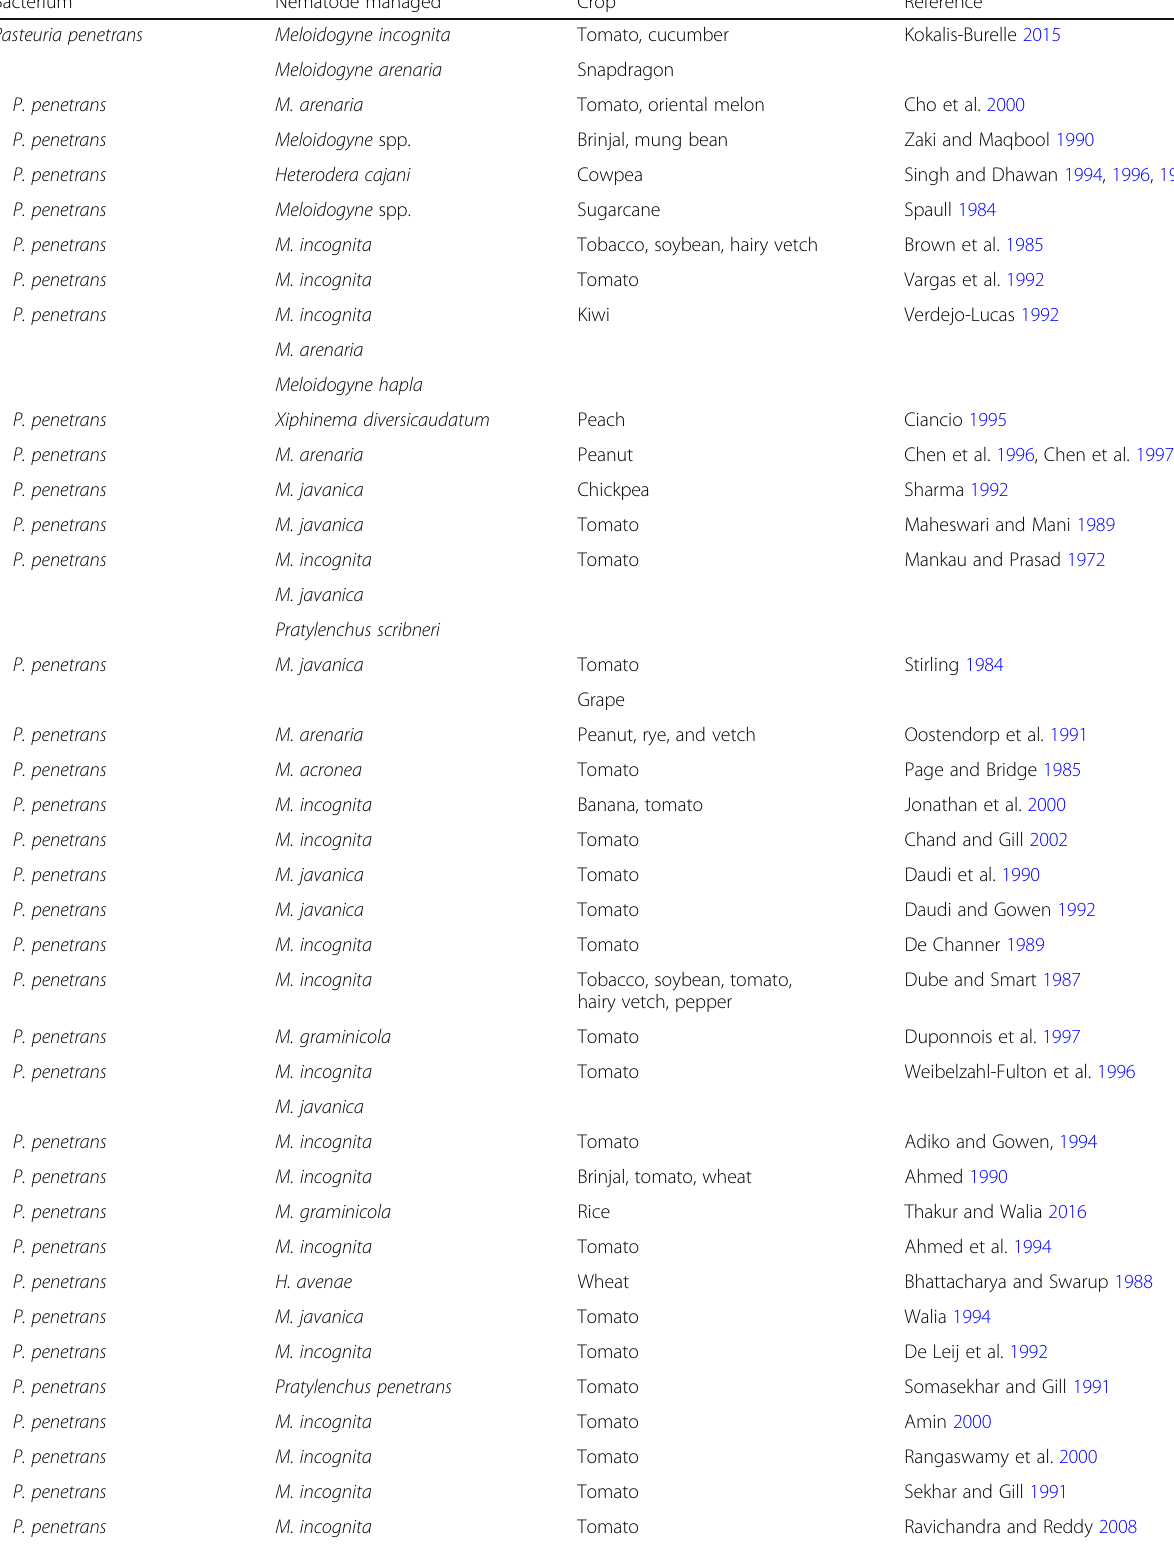
Table 6 List of bacterial biocontrol agents against phytonematodes infesting agricultural crops